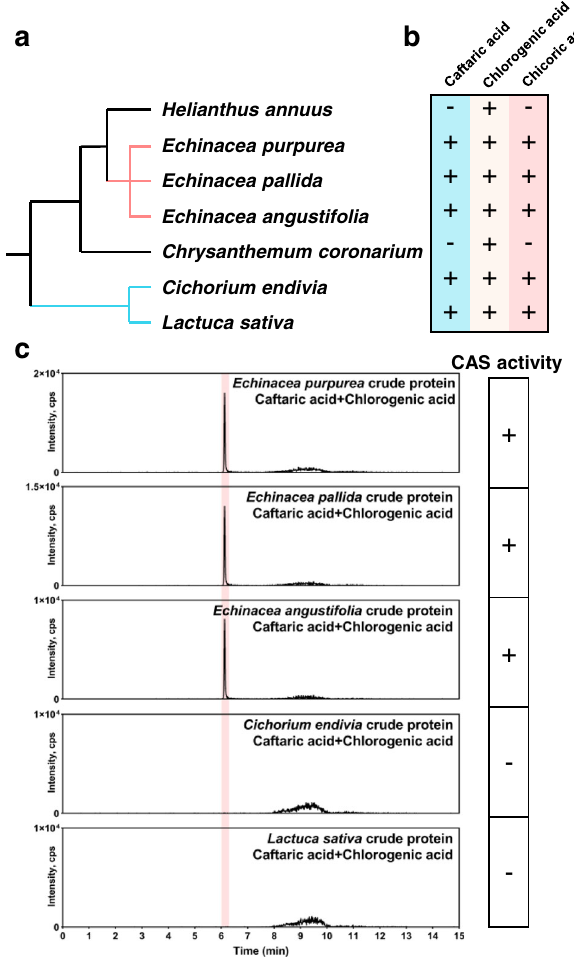
Fig. 5 Chicoric acid biosynthesis is polyphyletic between different species. a Phylogenetic relationships among several related species. Two Echinacea species ( Echinacea pallida and Echinacea angustifolia ) and two distantly related species ( Cichorium endivia and Lactuca sativa ) containing both substrates (caftaric acid and chlorogenic acid) and chicoric acid; as well as Helianthus annuus and Chysanthemum coronarium , from two intervening plant lineages which contain only chlorogenic acid were selected for the study of chicoric acid biosynthetic routes. The tree was adopted from NCBI taxonomy (http://lifemap-ncbi.univ-lyon1.fr/). b The presence of target compounds in each species. c CAS activities from different chicoric acid containing plant crude protein extracts. Only Echinacea species can use caftaric acid as an acyl acceptor and chlorogenic acid as an acyl donor to produce chicoric crude protein extracts from the other chicoric acid-producing species with caftaric acid and chlorogenic acid, E. pallida and E. angustifolia crude protein extracts showed CAS activities.